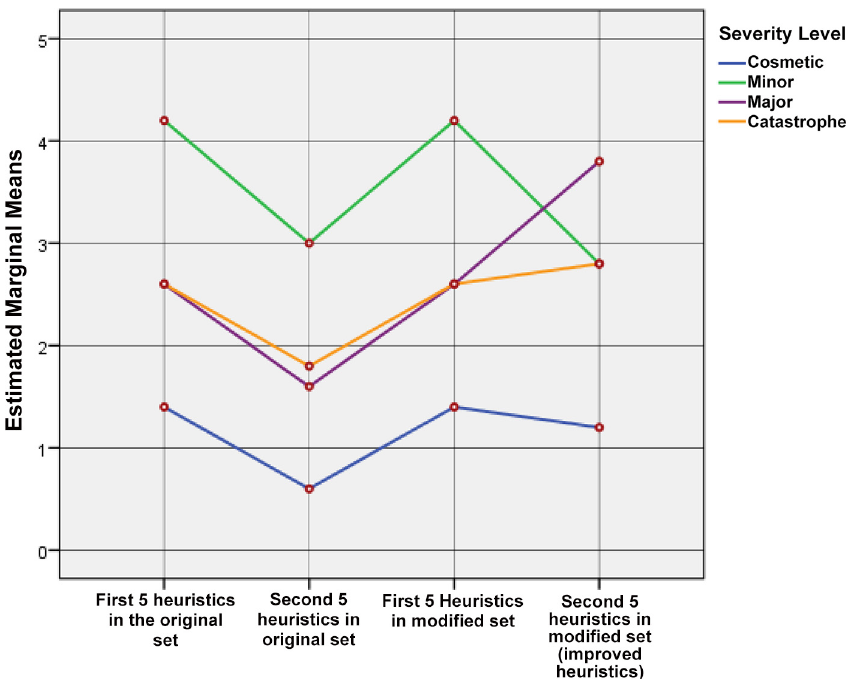
Fig 9. Estimated marginal means of problem identification among four groups at different severity levels.